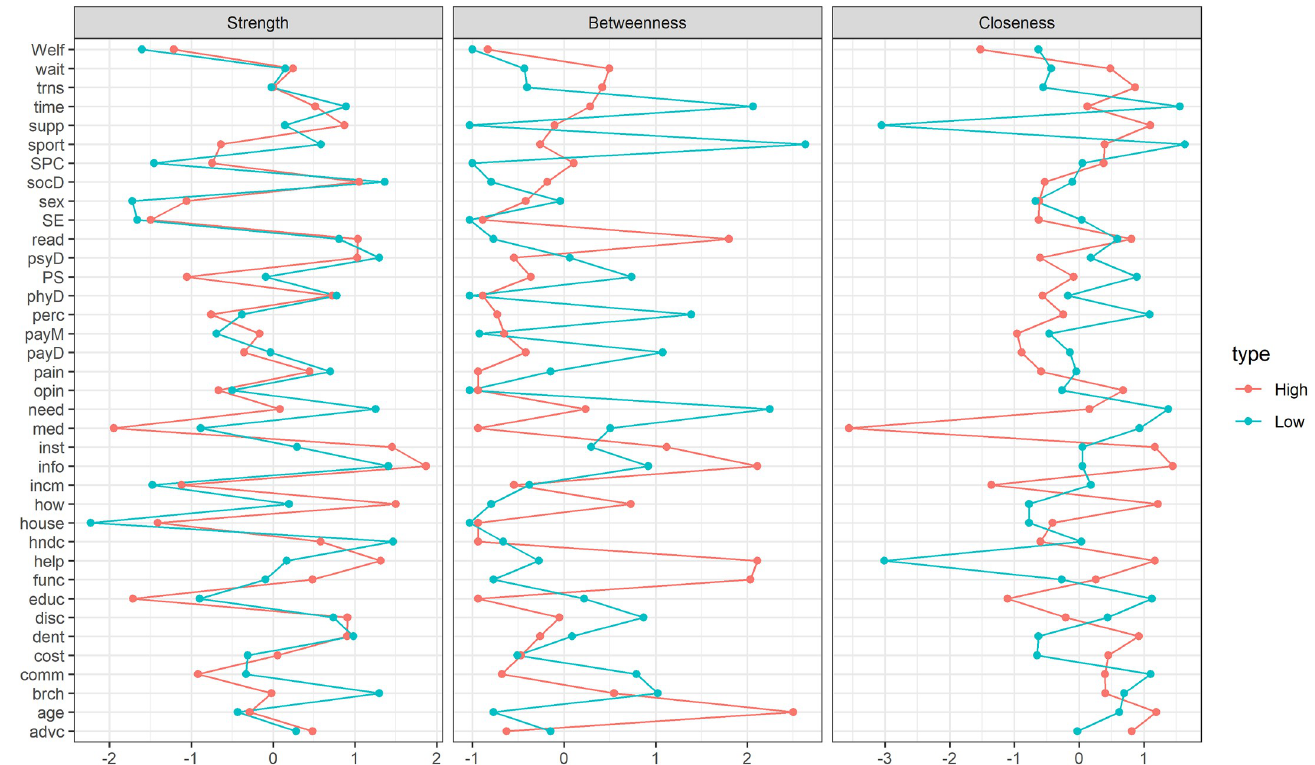
Fig 4. Comparison of network structures comprising participants with low and high oral health literacy,